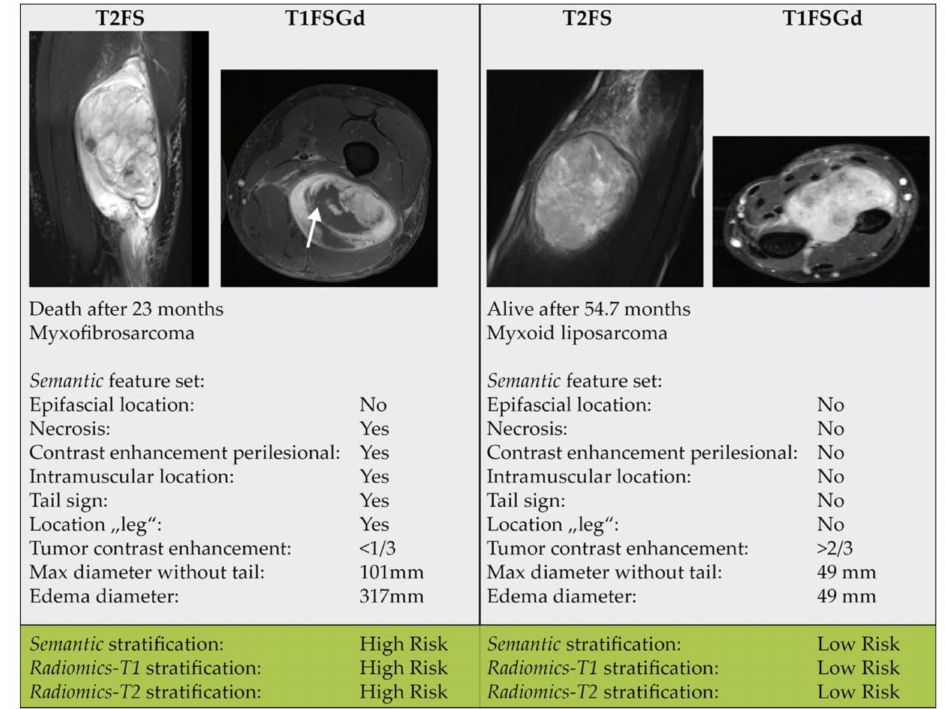
Figure 6. Two exemplary patient